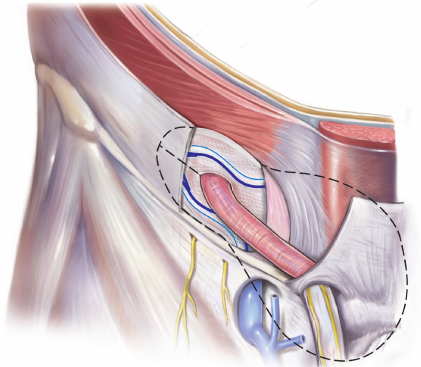
Figure13: Thelateral partof themeshisplaced inthespacebetween the internal and external aponeurosis, and the medial part of the mesh is positioned in the preperitoneal space.